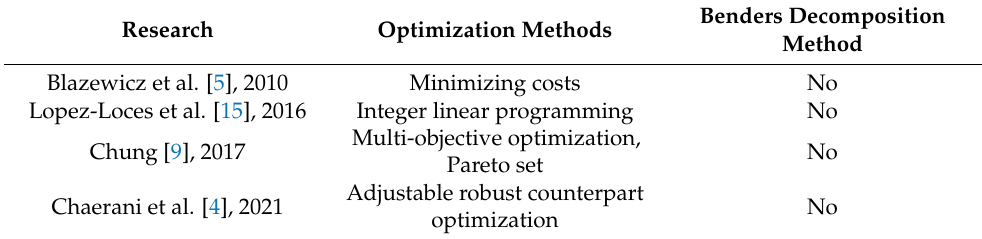
Table 1. State of the art for